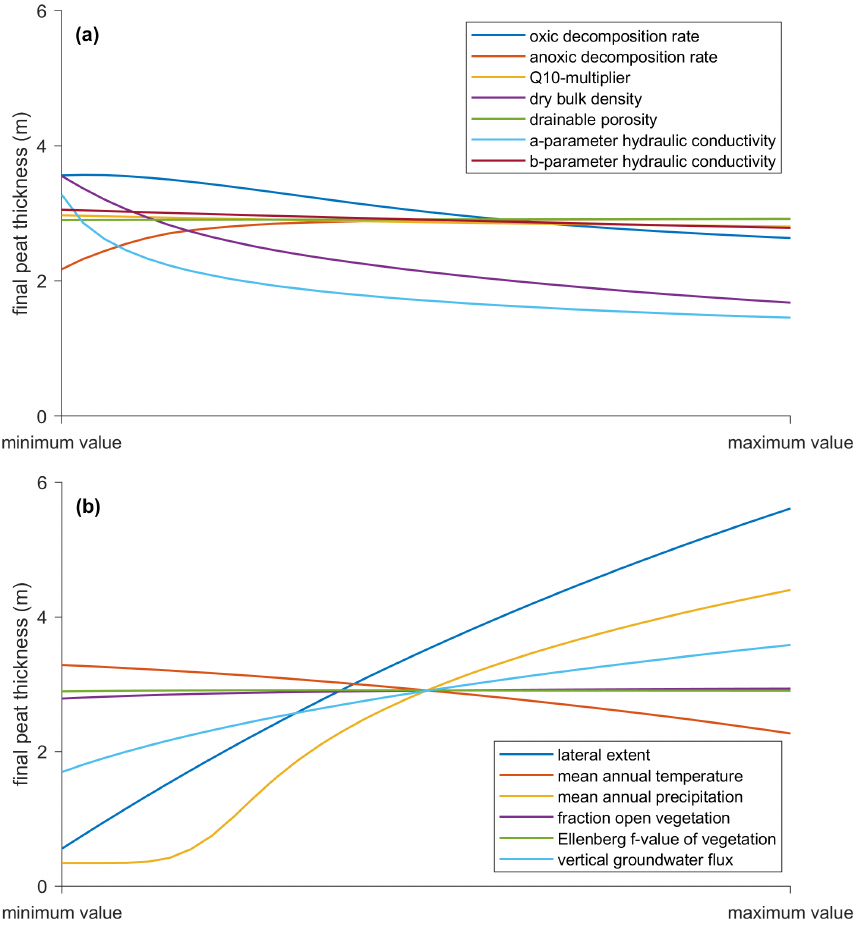
Figure 4. Final peat thickness (m) for (a) all variables used in the one-at-a-time (OAT) parameter sensitivity test for model parameters related to peat properties and (b) external factors including the peatland vegetation, climatic conditions and hydrology. Each parameter is varied over the range mentioned in Table A6 in the